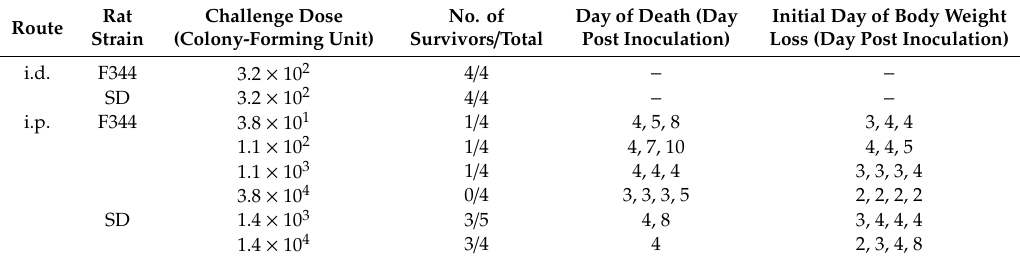
Table 1. Virulence of Francisella tularensis NVF1 to rats.